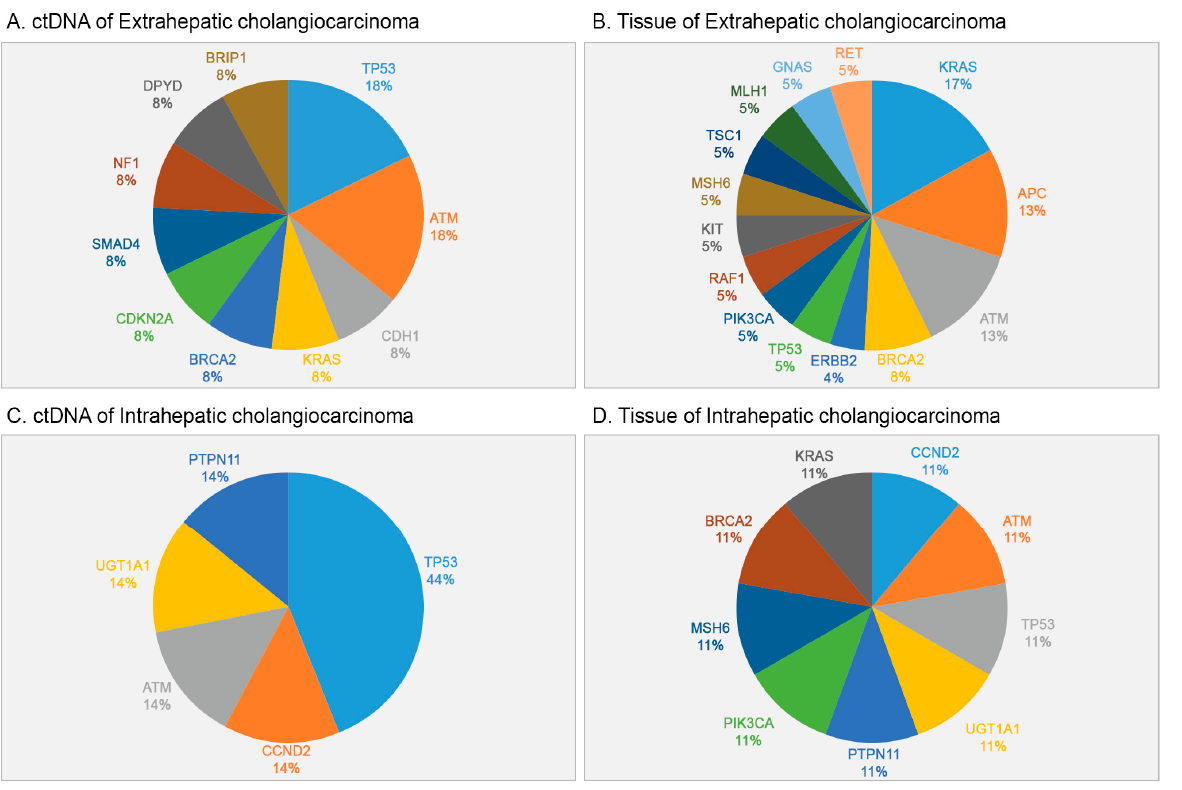
Figure 4. Frequency of alterations of mutated genes in ( A , C ) preoperative ctDNA samples and ( B , D ) corresponding tumor samples from patients with ( A , B ) extrahepatic cholangiocarcinoma and ( C , D ) intrahepatic cholangiocarcinoma.